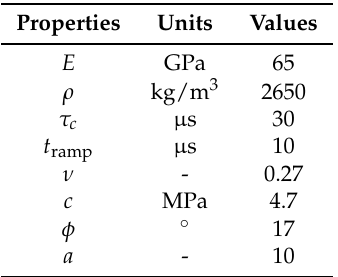
Figure 5. Problem description for a rectangle subject to a vertical compressive loading. Table 1. Material